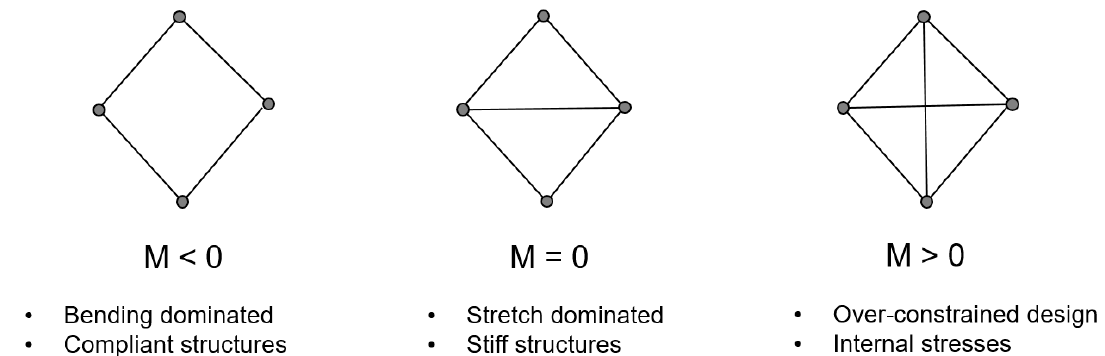
Figure 4. The relationship between Maxwell’s stability criterion and stretch- and bending-dominated structures [12,13].